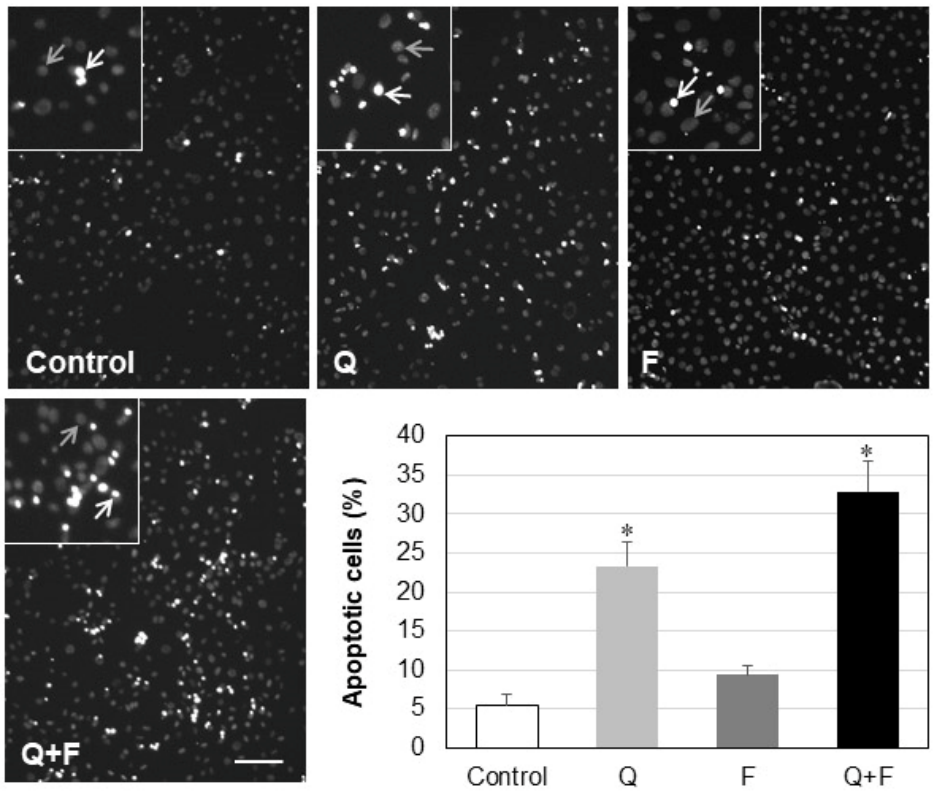
Figure 8. Apoptotic response of HepG2 cells after treatment with quercetin (Q), fingolimod (F) or combination of both drugs (Q + F). Apoptotic (white arrows in the insets) and non-apoptotic (gray arrows in the insets) nuclei were scored, and the percentage of apoptotic cells in each sample was determined. Bar, 100 µm. * p < 0.001.